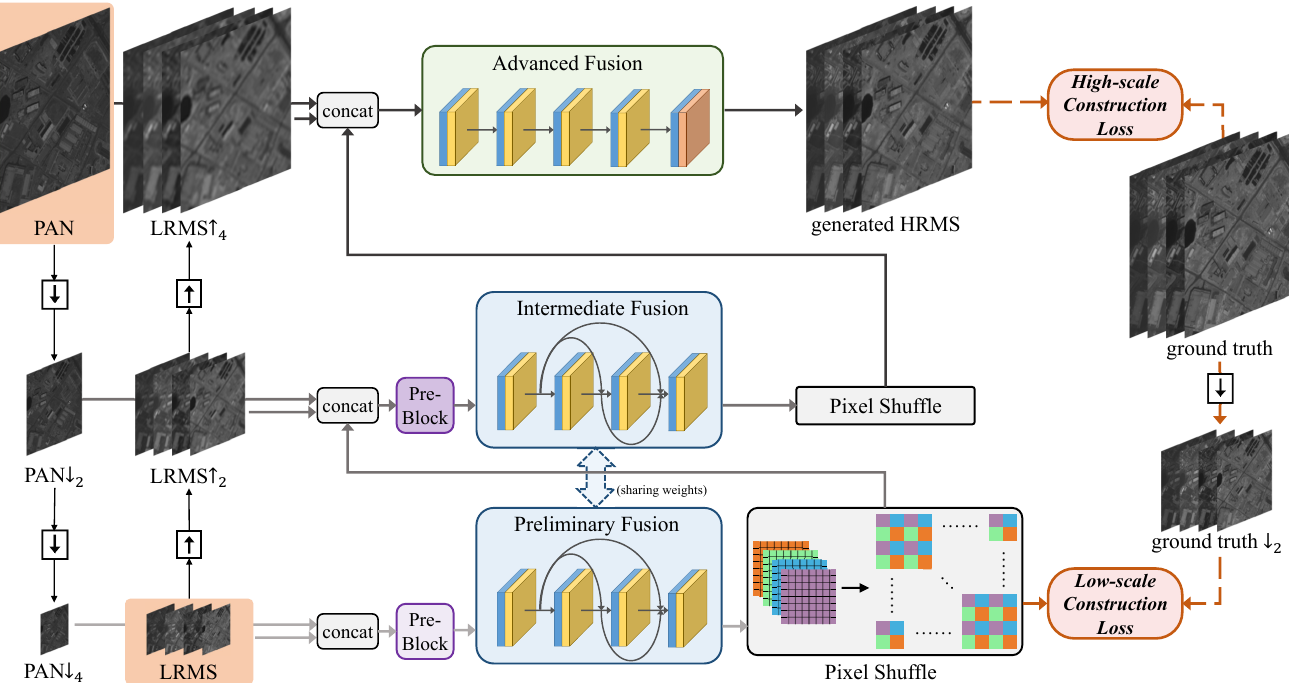
Figure 1. The whole framework of the proposed CPNet. The images in the reddish brown background are the source images (PAN and LRMS images). The I ↑ x /I ↓ x denotes image I after up-sampling/down-sampling x times the